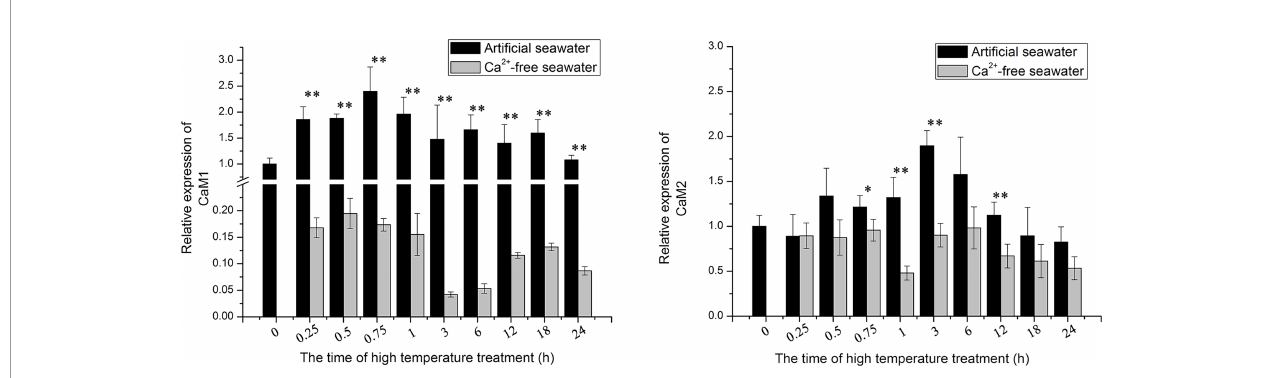
FIGURE 3 | Transcript levels of NhCaM in N. haitanensis at different times under heat stress. * and ** represent signi fi cant difference (P < 0.05) and extremely signi fi cant difference (P<0.01) between the same time point in different treatment groups,